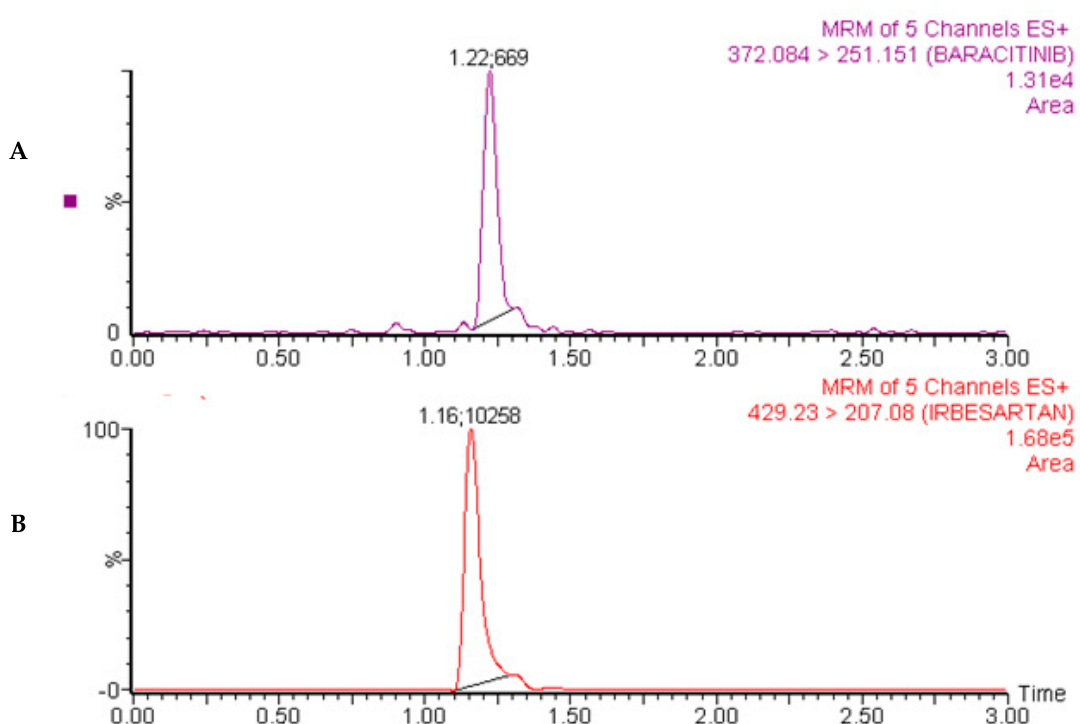
Figure 4. MRM Chromatograms of baricitinib ( A ) and internal standard ( B ) in real rat plasma sample obtained at 1.0 h following oral administration of 2 mg/kg baricitinib.